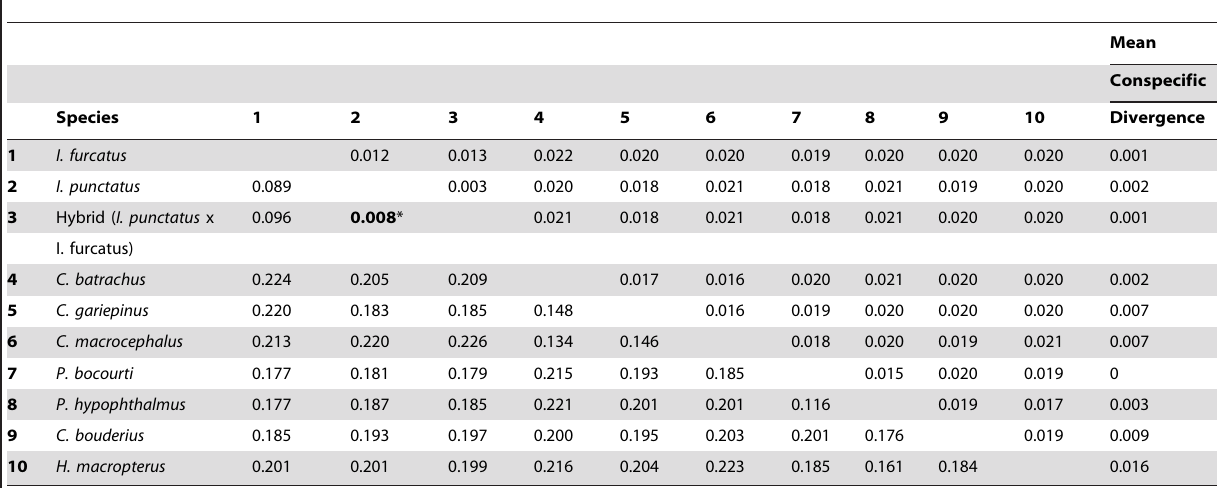
Table 4. Estimates of Pairwise Genetic Distances between Catfish Species under Kimura 2-Parameter Model [18].